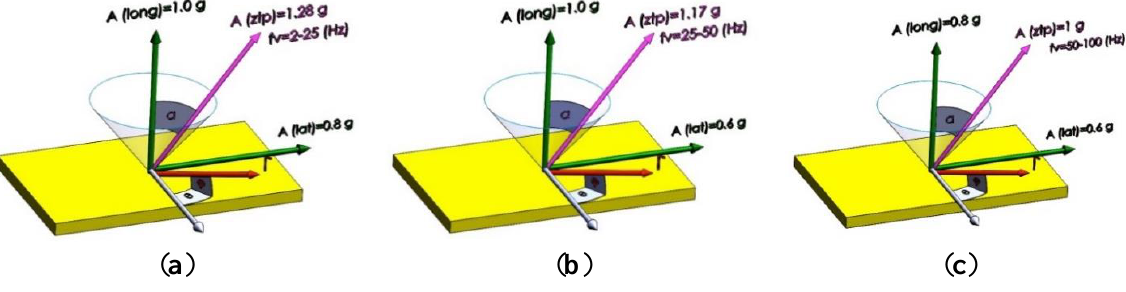
Figure 15. Magnitude and angular orientation of sinusoidal vibrations. ( a ) α = 38.7°; ( b ) α = 31°; ( c ) α =